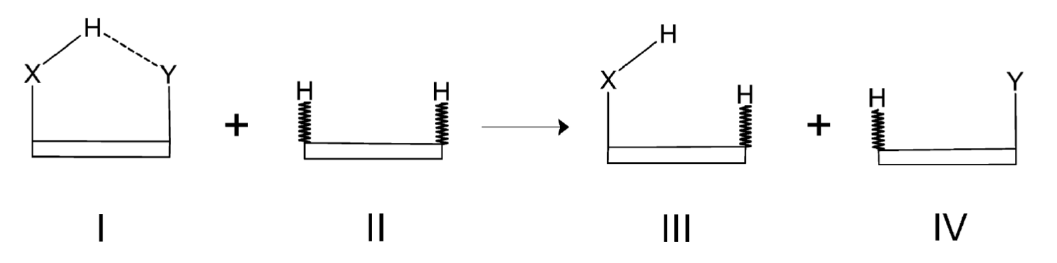
Figure 20. General scheme showing a homodesmotic reaction for a model molecule featuring an intramolecular X-H · · · Y hydrogen